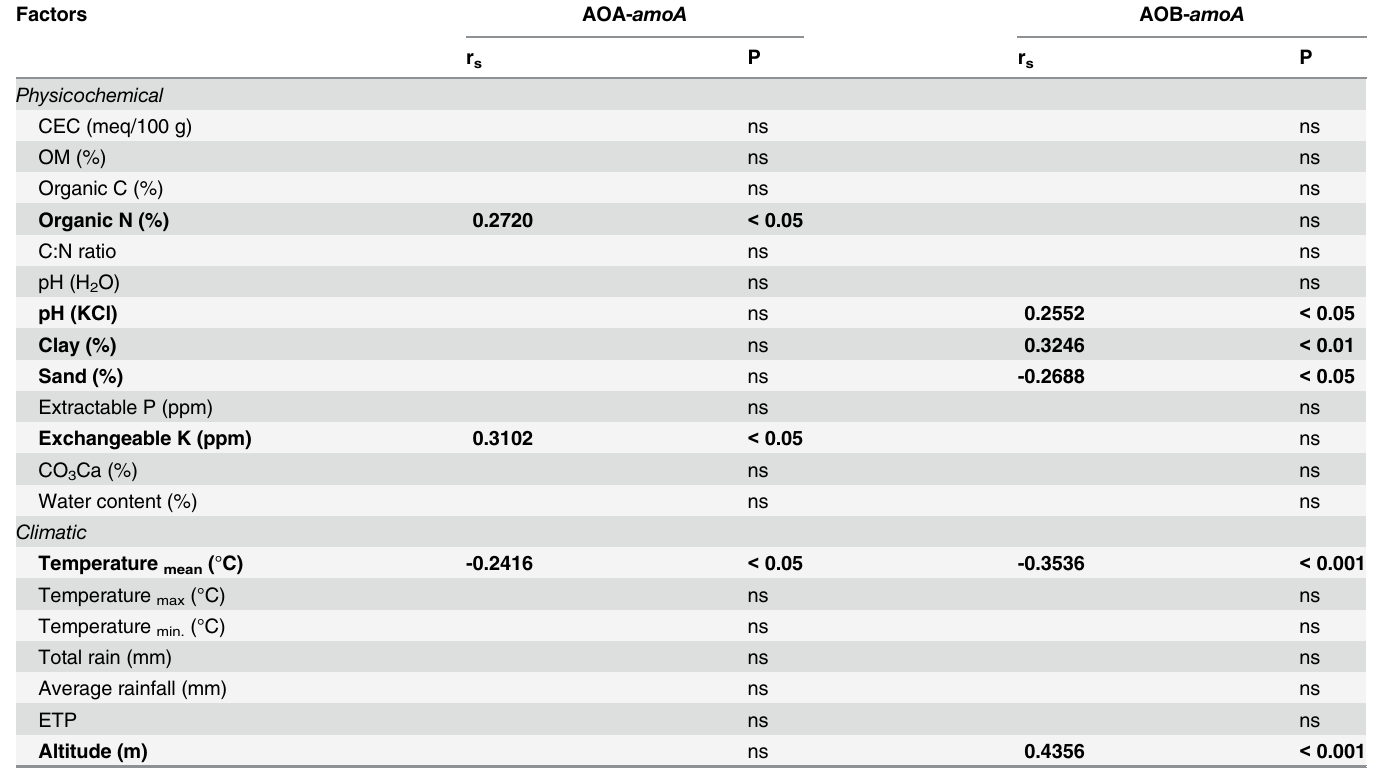
Table 3. Spearman's rank correlation between the concentration of amoA genes copies and environmental parameters for AOA and AOB in the olive trees